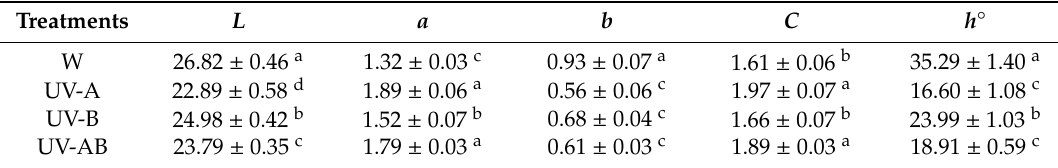
Table 1. Color value of tea leaves.